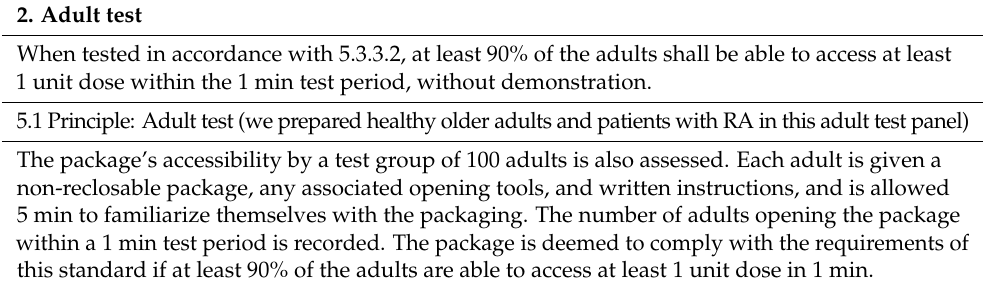
Figure 3. Ease of opening of sample Type B1. The score is the subjective evaluation after the CR adult test in the group of older adults. Table 1. EN 14,375 child and adult test (for non-reclosable packaging).